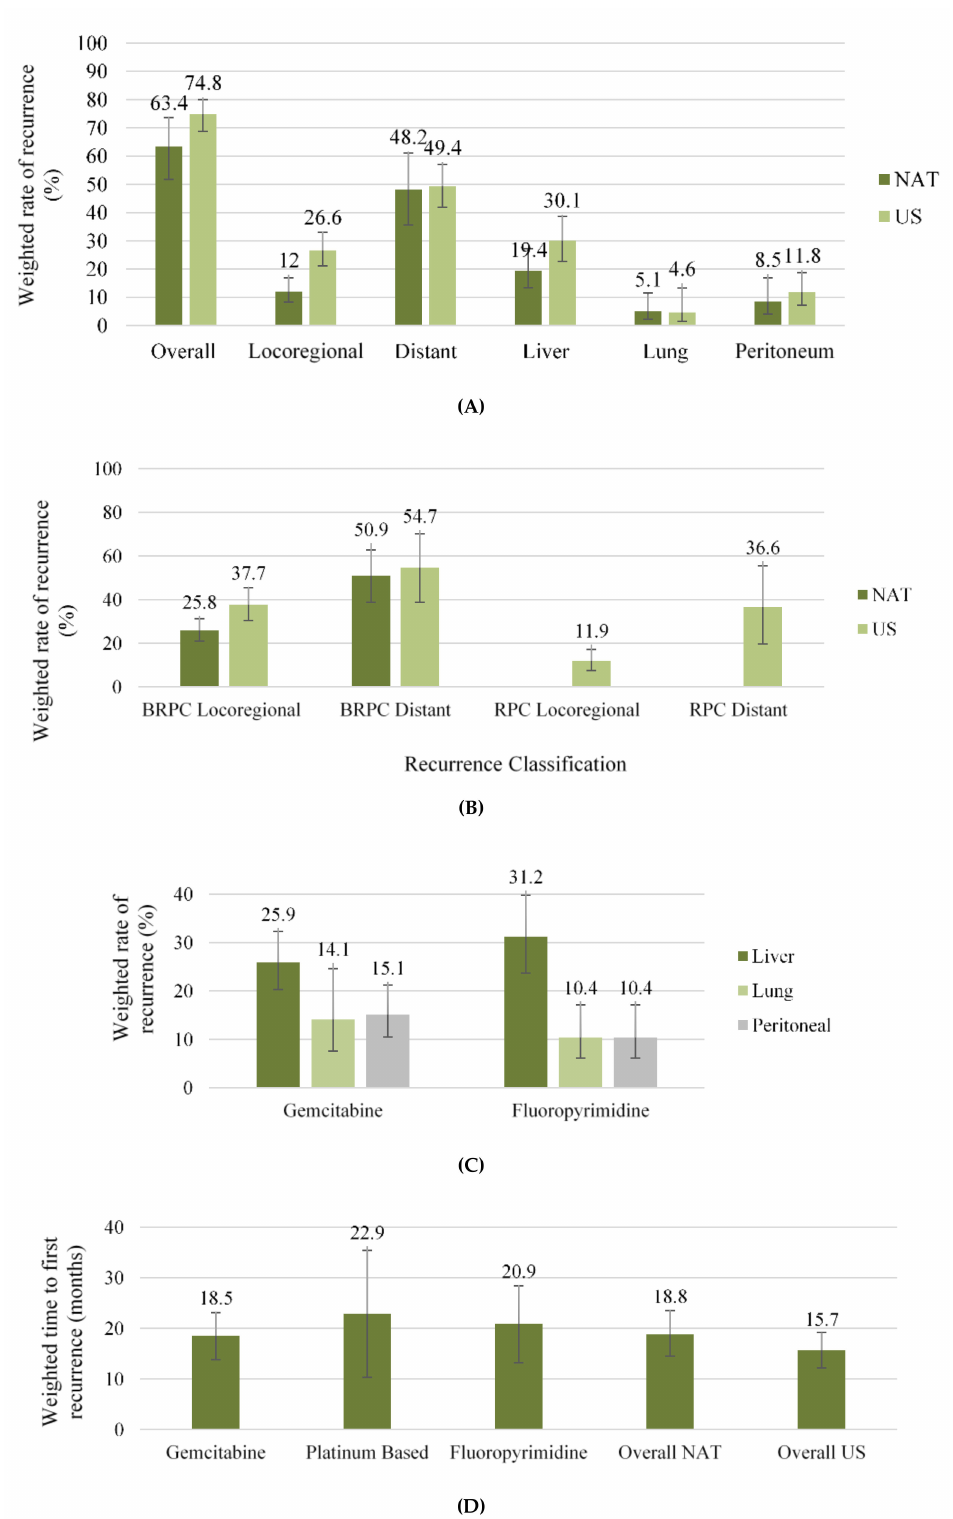
Figure 3. Weighted estimates of: ( A ) Site-specific rates of recurrence; ( B ) Resectability-specific sites of recurrence; ( C ) NAT-specific rates of distant organ-specific recurrence; ( D ) NAT-specific time to first recurrence. Ninety-five percent confidence intervals are denoted by the central bar. Neoadjuvant therapy (NAT); Up-front Surgery (US); Borderline resectable pancreatic cancer (BRPC); resectable pancreatic cancer